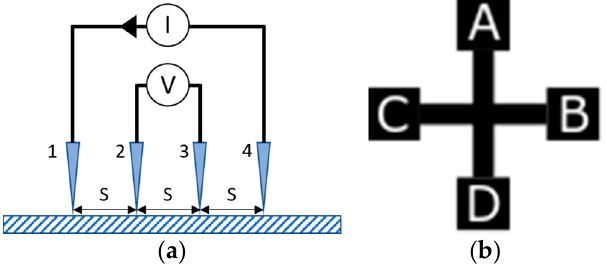
Figure 1. ( a ) Schematics of a four-probe measurement assembly; ( b ) Typical symmetrical cross structure for a Van-der-Pauw’s four-point-probe-measurement.